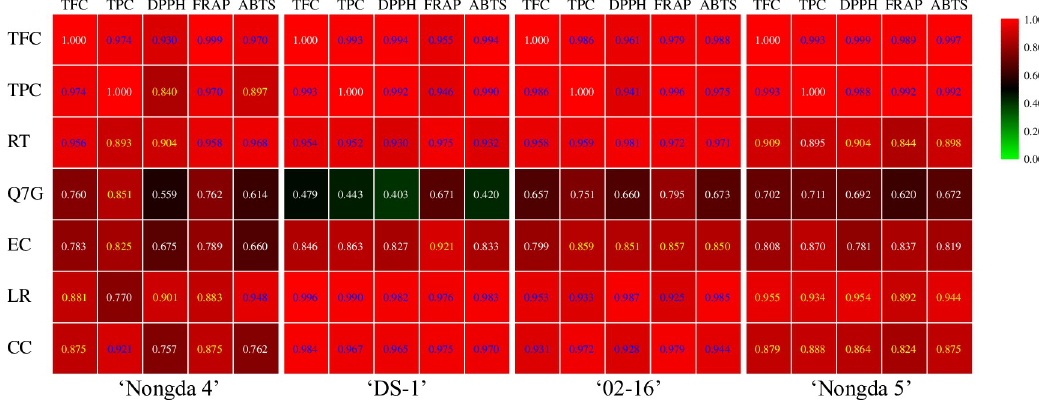
Fig 6. Correlations among bioactive components and antioxidant indices in Prunus humilis fruit. Note: Positive number, positively correlated. The blue numbers indicate a significant correlation at the 0.01 level, the yellow numbers indicate a significant correlation at the 0.05 level. TFC, total flavonoid content; TPC, total phenol content; DPPH, 2,2-diphenyl-1-picrylhydrazyl free radical scavenging capacity; FRAP, ferric reducing antioxidant power; ABTS, 2,2’-azinobis (3-ethylbenzothiazoline-6-sulfonic acid) free radical scavenging capacity; CC, catechin; EC, epicatechin; LR, liquiritigenin; RT, rutin; Q7G, quercetin-7-O- β -D-